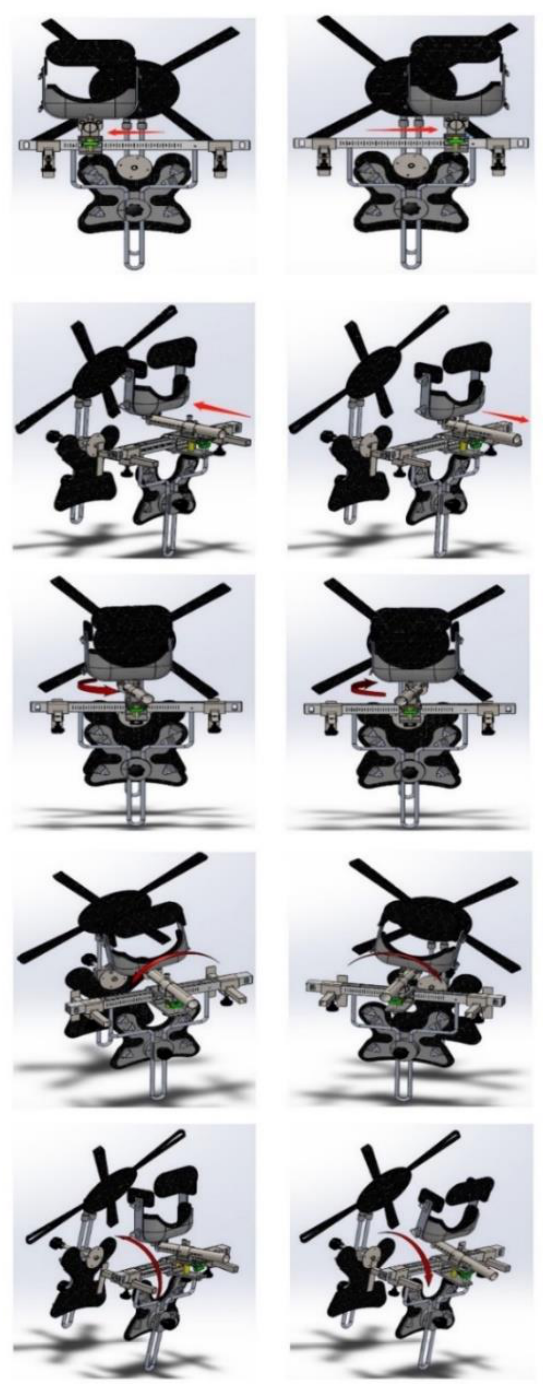
Figure 4. Posture corrective orthotic (PCO) demonstrating the availability to move in different directions and lock the head in its opposition position. Top row: lateral translation of the head left and right (Tx). Second row: anterior and posterior translation of the head (Tz). Third row: rotation of the head about vertical gravity left and right (Ry). Fourth row: side bending of the head left and right (Rz). Bottom row: extension and flexion of the head (Rx). See Figure 5 for a sample patient setup.